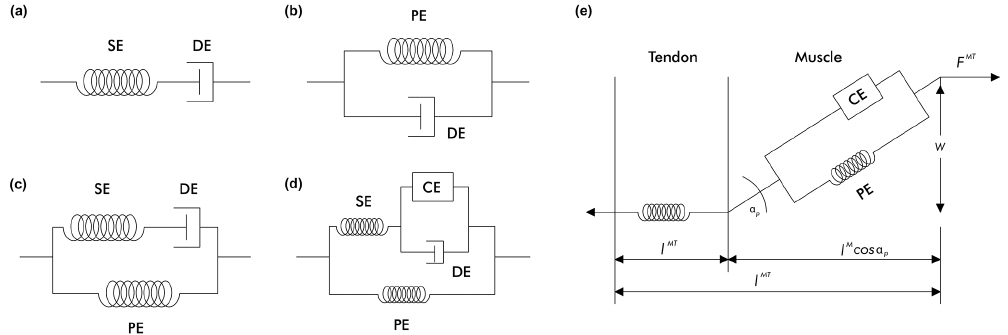
Figure 1. Muscle models (tendon not included in a-d models). (a) Maxwell model. (b) Voigth model. (c) Kelvin model. (d) Hill model. (e) Nomenclature used in the Hill-type muscle